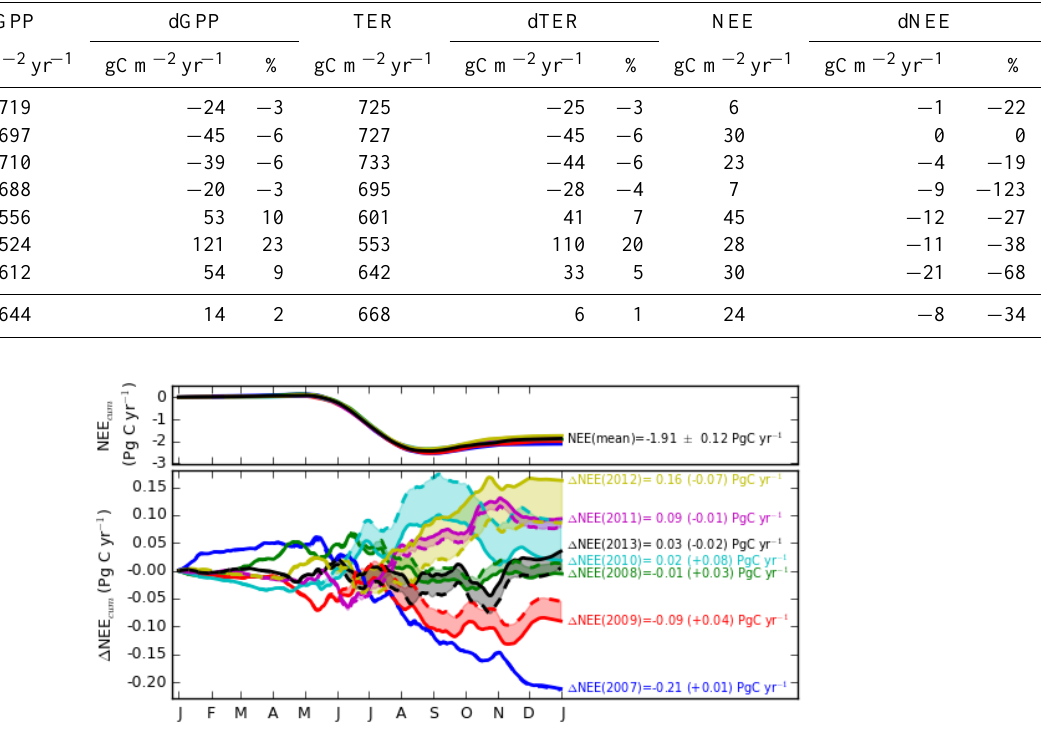
Table 3. GPP, TER, and NEE in SiBCASA without ASCAT soil moisture assimilation, and the changes dGPP, dTER, dNEE with assimilation for the site Yakutsk Larix.